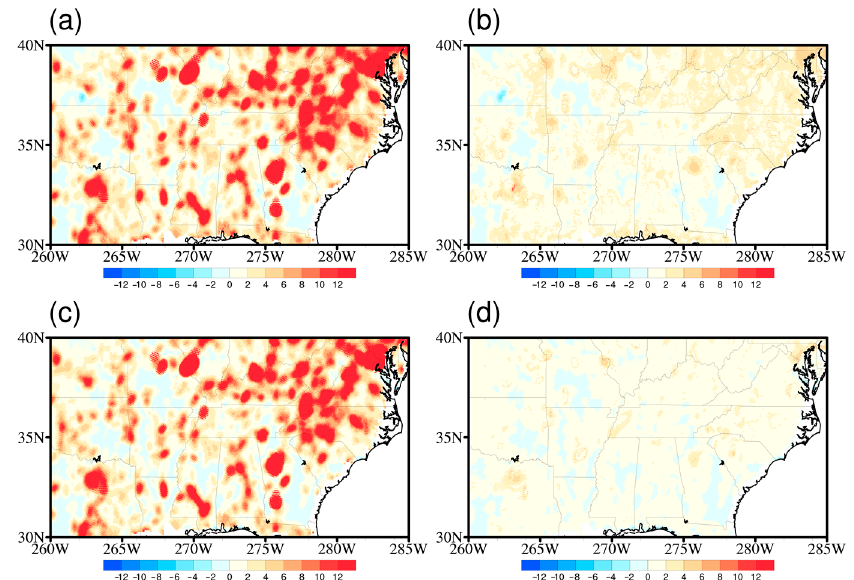
Figure 5. Spectral difference between the observed 6.9-GHz-V channel and the 7.3-GHz-V ( a ) and 10.7-GHz-V ( c ) channels, respectively, and the restored 6.9-GHz-V channel and observed 7.3-GHz-V ( b ) and 10.7-GHz-V ( d ) channels in autumn 2016.